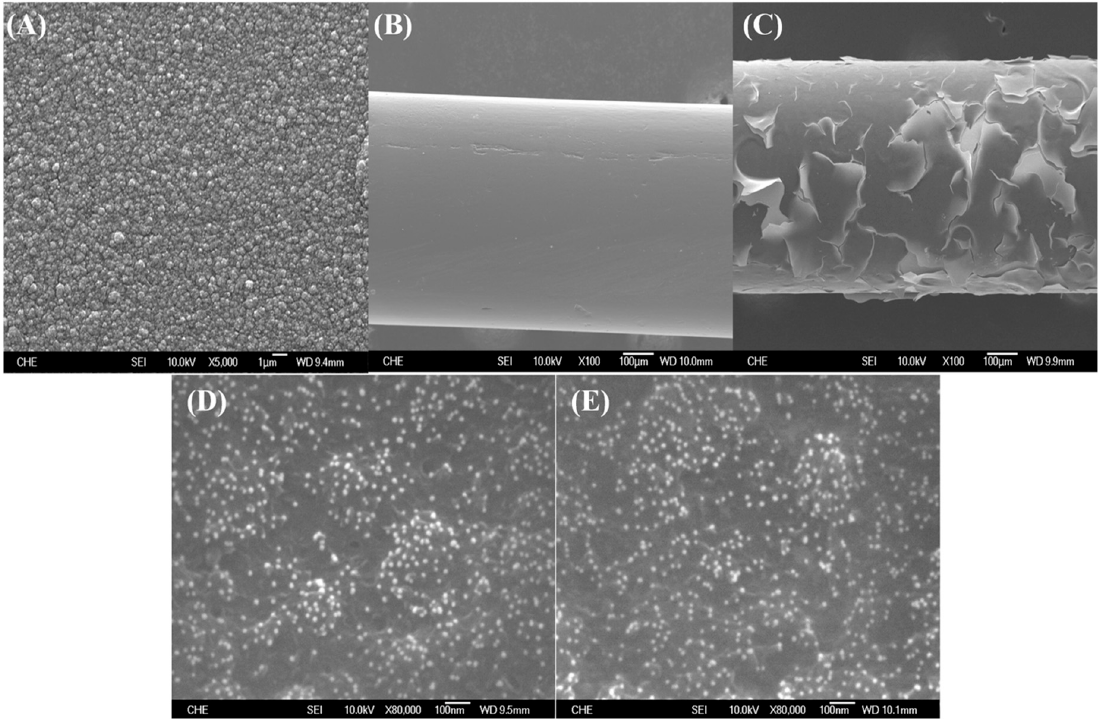
Figure 2. SEM analysis of the electrochemically synthesized PEDOT film on a Pt electrode at ( A ) 5000 × magnification, at 100 × magnification ( B ) before and ( C ) after DPV measurement (potential window: 0–1 V), and of non-cracked PEDOT films with the adsorption of Au NPs ( D ) before and ( E ) after DPV